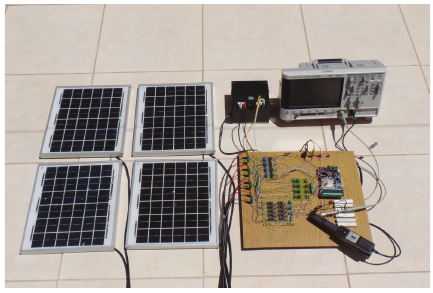
Figure 11: Reconfiguration system.